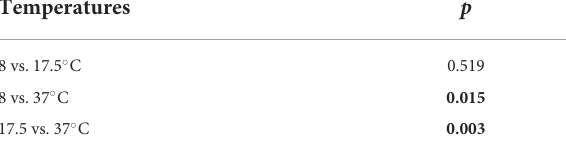
TABLE 4 Comparison of phagocyte activity in the first measurement (LSD post-hoc test) between cells preincubated for 24 at